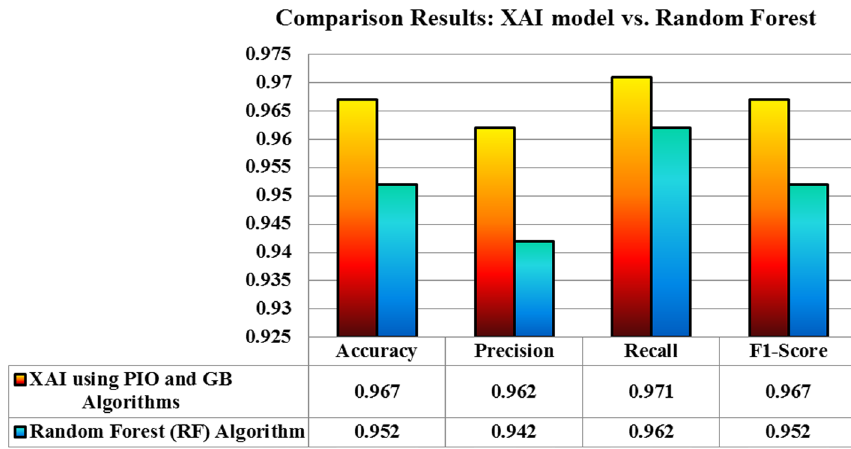
Fig. 8 Comparison results: the proposed XAI model vs. Random Forest classifier in rec- ognizing financial crisis roots